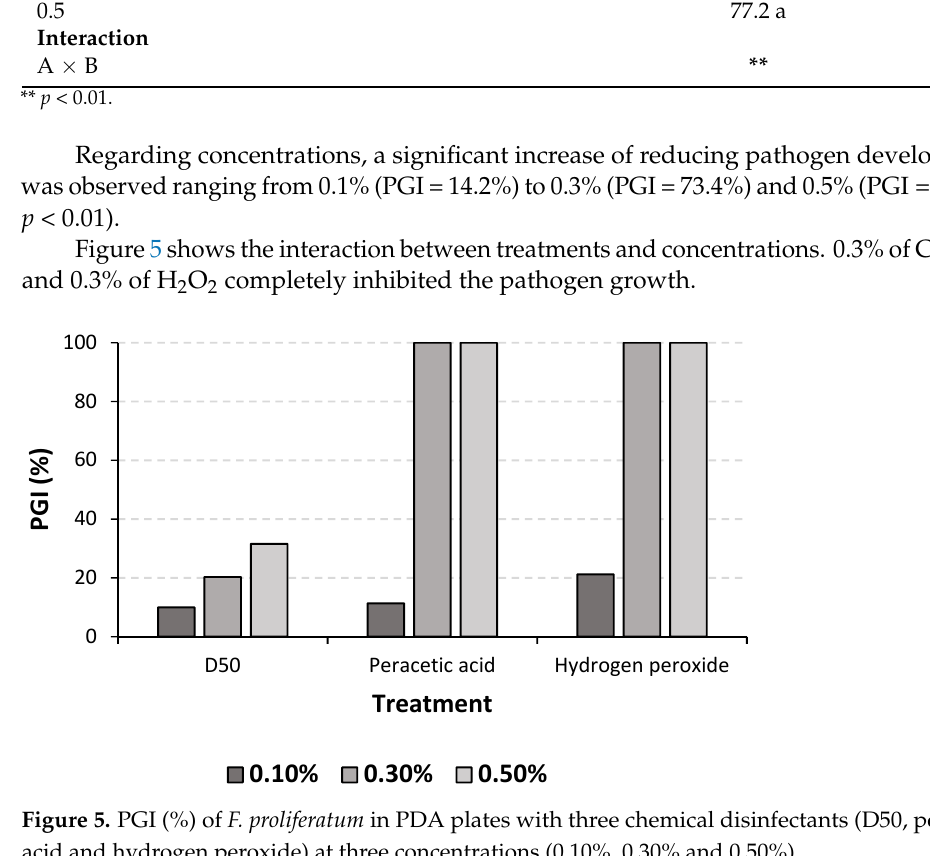
Table 6. Analysis of variance of CFU·g − 1 and seed germination (%) at the end of the in vivo trial with chemical disinfectants. 0.3% of hydrogen peroxide or 0.3% of peracetic acid were applied to garlic cloves divided in the two quality categories (first category cloves length > 15 mm, second category 10–15 mm clove length). Two different application systems were tested (spray and immersion). Dif- ferent letters indicate significant differences according to Tukey’s test ( p < 0.01).